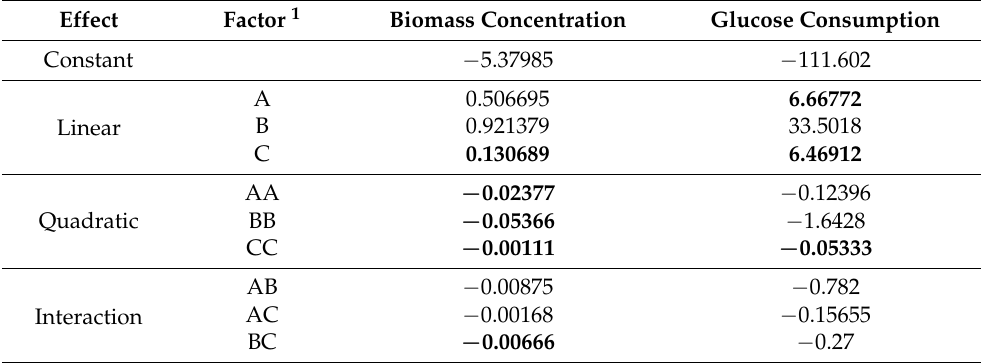
Table 2. Regression coefficients of the predicted second order polynomial models for biomass concentration and glucose consumption.